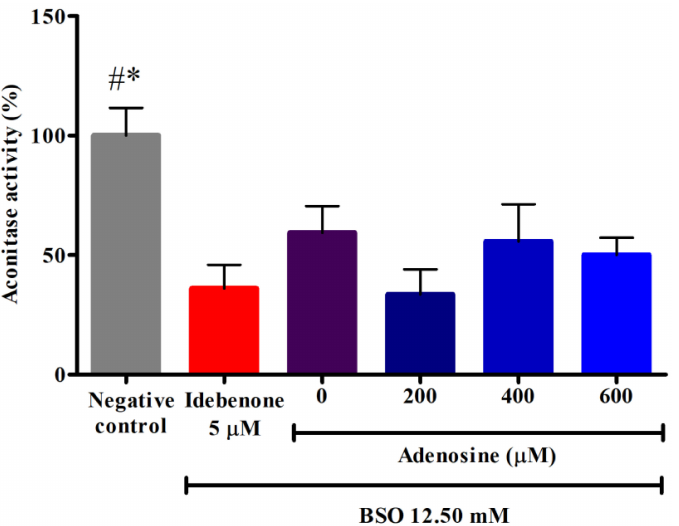
Figure 3. Effects of adenosine on the aconitase activity in FRDA fibroblasts treated with BSO. Aconitase activity was evaluated following pre-treatment with adenosine for 2 h and 12.50 mM BSO for 24 h. Data are expressed as mean ± SD and statistically analyzed by one-way ANOVA with Tukey’s post-hoc test. Hash (#) and asterisk (*) indicate significant differences ( p < 0.05) in aconitase activity compared to the idebenone group and BSO-treated (0 µ M adenosine) group, respectively. BSO, L-buthionine